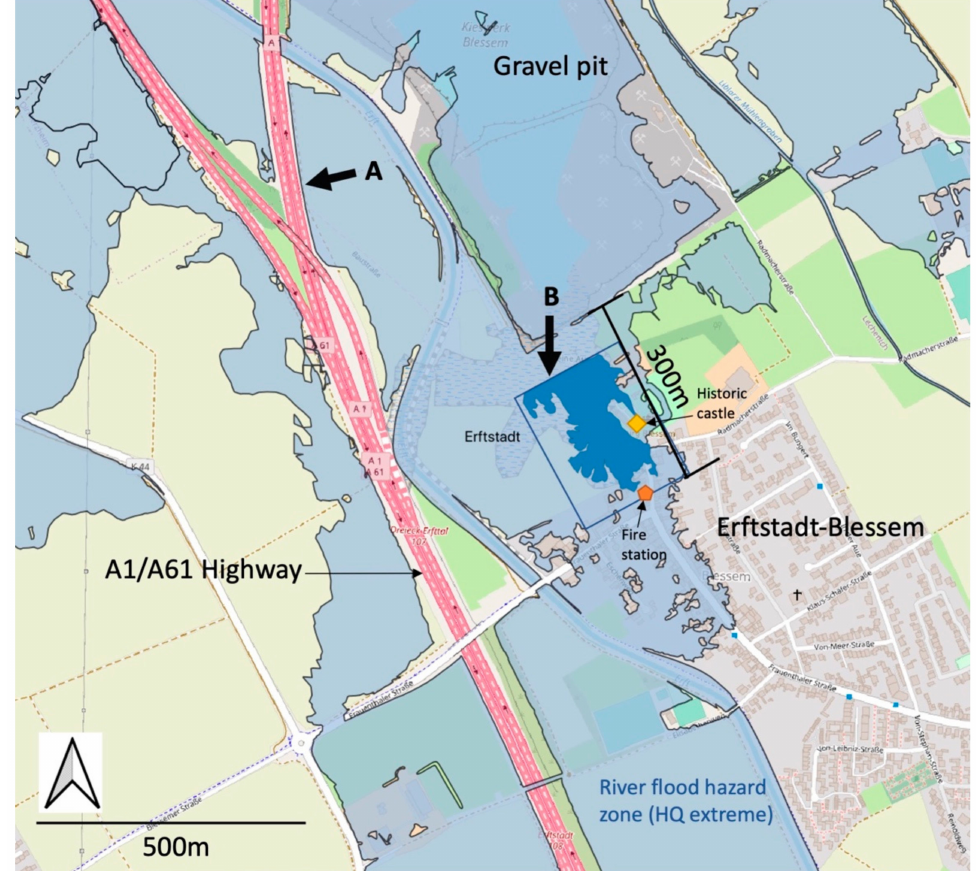
Figure 5. Riverine flood maps covering Erftstadt and the heavily flooded parts of Erftstadt-Blessem with an example of a mapping issue ( A ) and a backward erosion area caused by the floods ( B